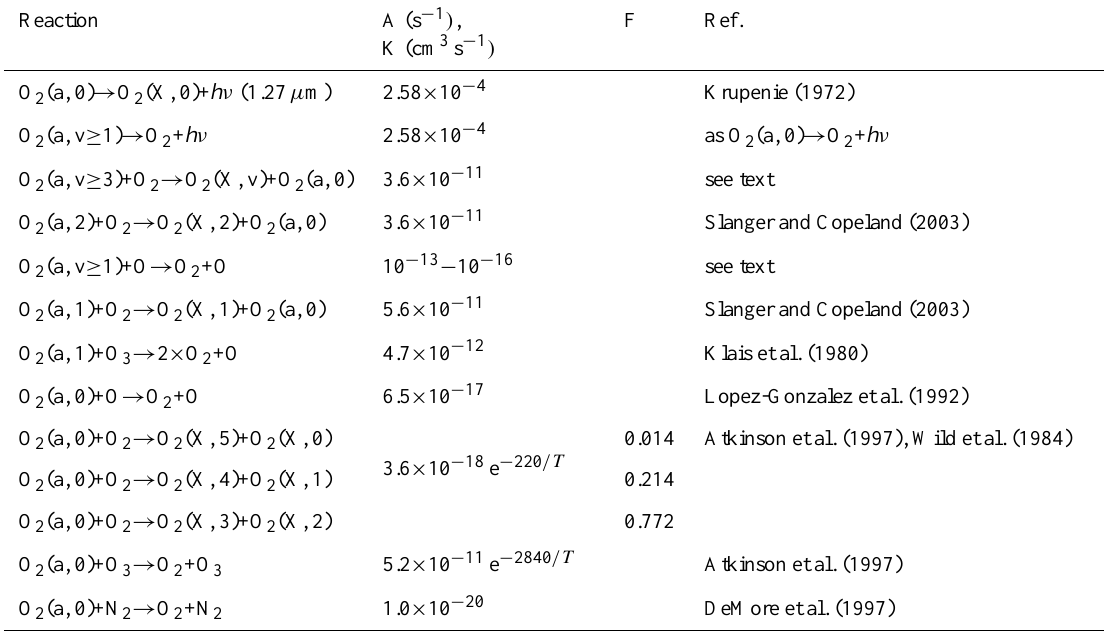
Table 4. Processes of deactivation of O 2 (a 1 1 g , v). Symbols as in Tables 1 and 2. Reaction Ref.